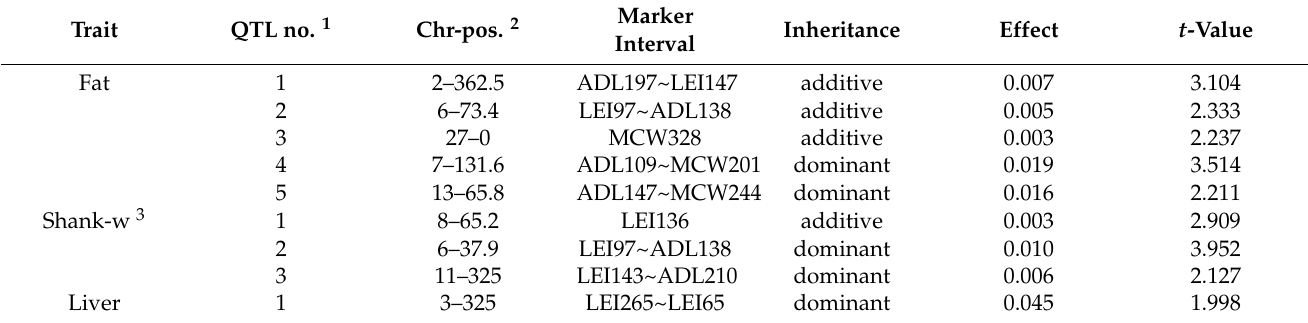
Table 1. QTLs for the allometric scalings of 3 body compositions to body weights. Trait